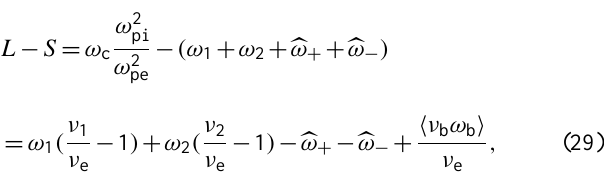
Fig. 2. Curves similar to those of Fig. 1, but for a plasma contami- nation by negative CS − ions of relative charge density ν 4